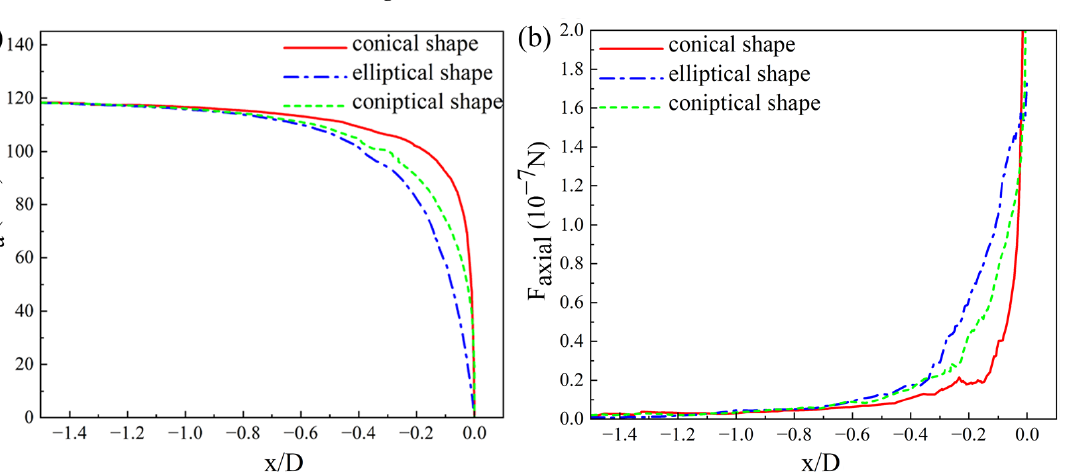
Figure 7. Aerodynamic force analysis of water droplets at 𝑟/𝑅 = 0 . ( a ) Axial velocity of air 𝑢 𝑎 ; ( b ) axial force of water droplets 𝐹 𝑎𝑥𝑖𝑎𝑙 .